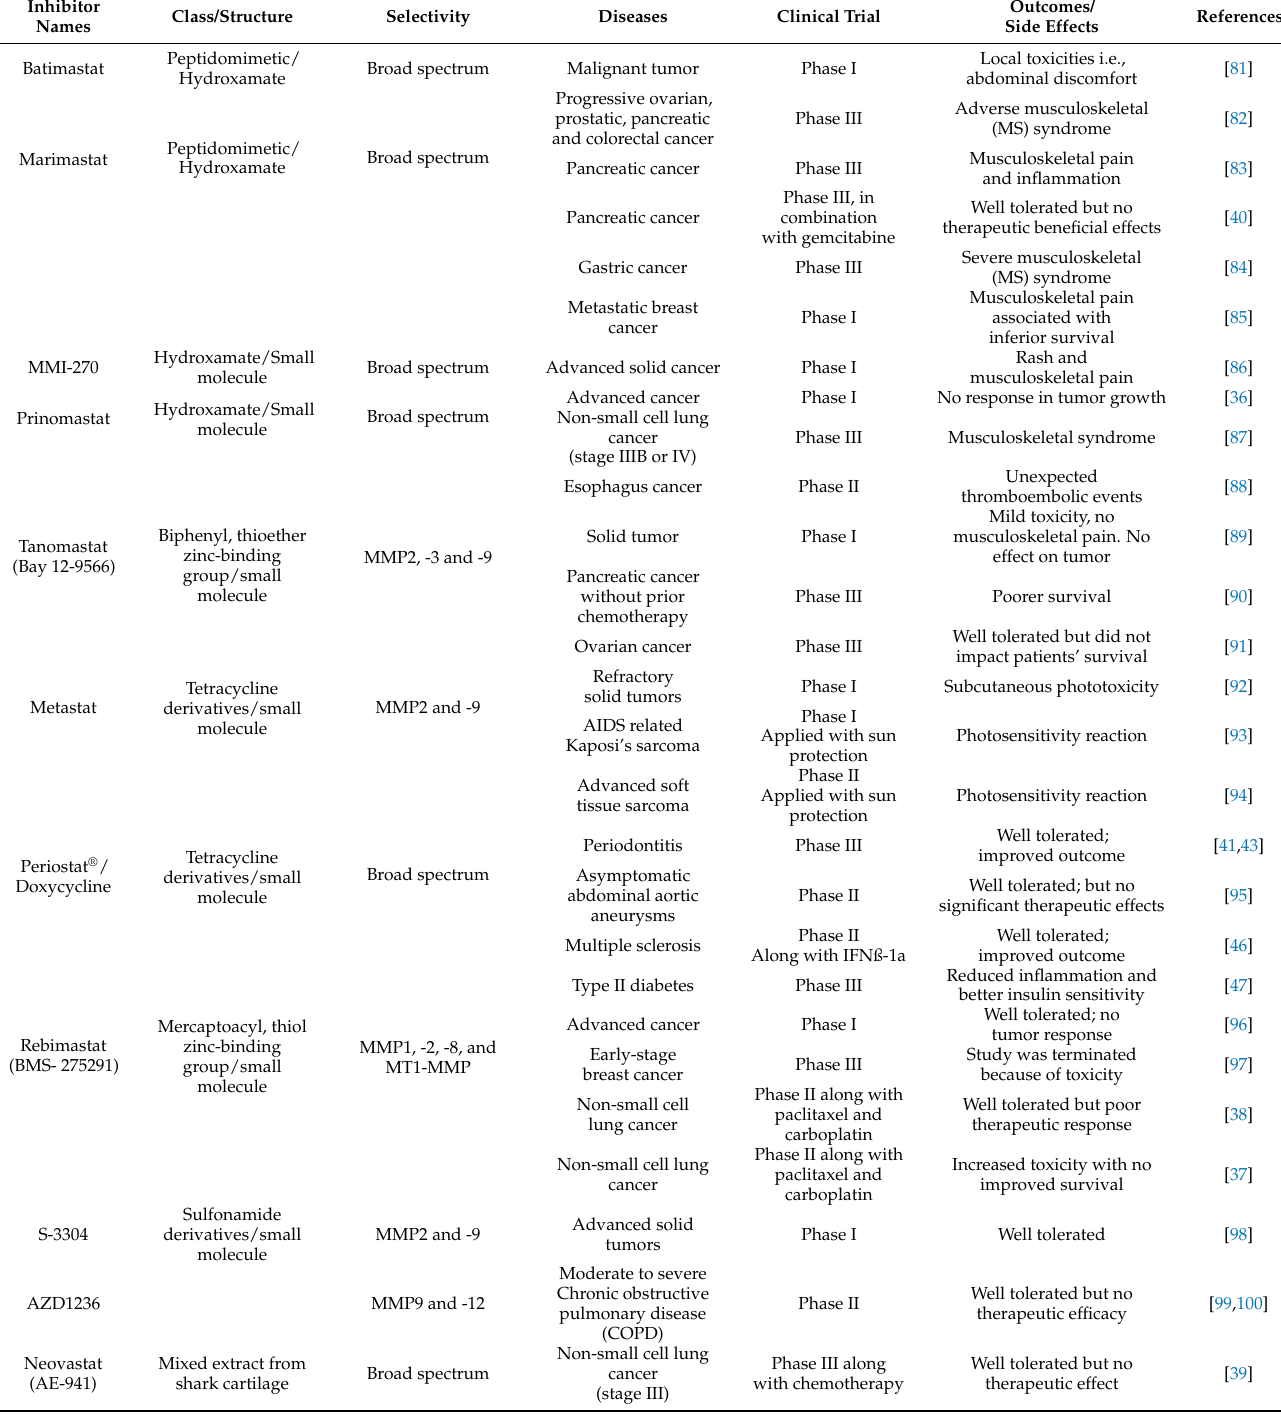
Table 1. MMPs inhibitors in clinical